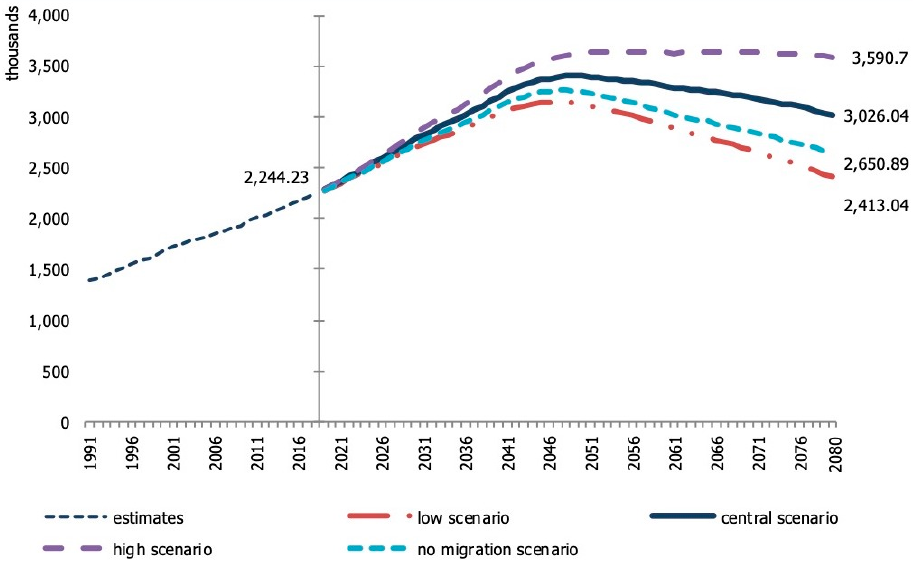
Figure 1. Resident population, 65 and over age group, Portugal, 1991–2080 (estimate and projections) Source: PORDATA and INE. © Instituto Nacional de Estatística [8] .